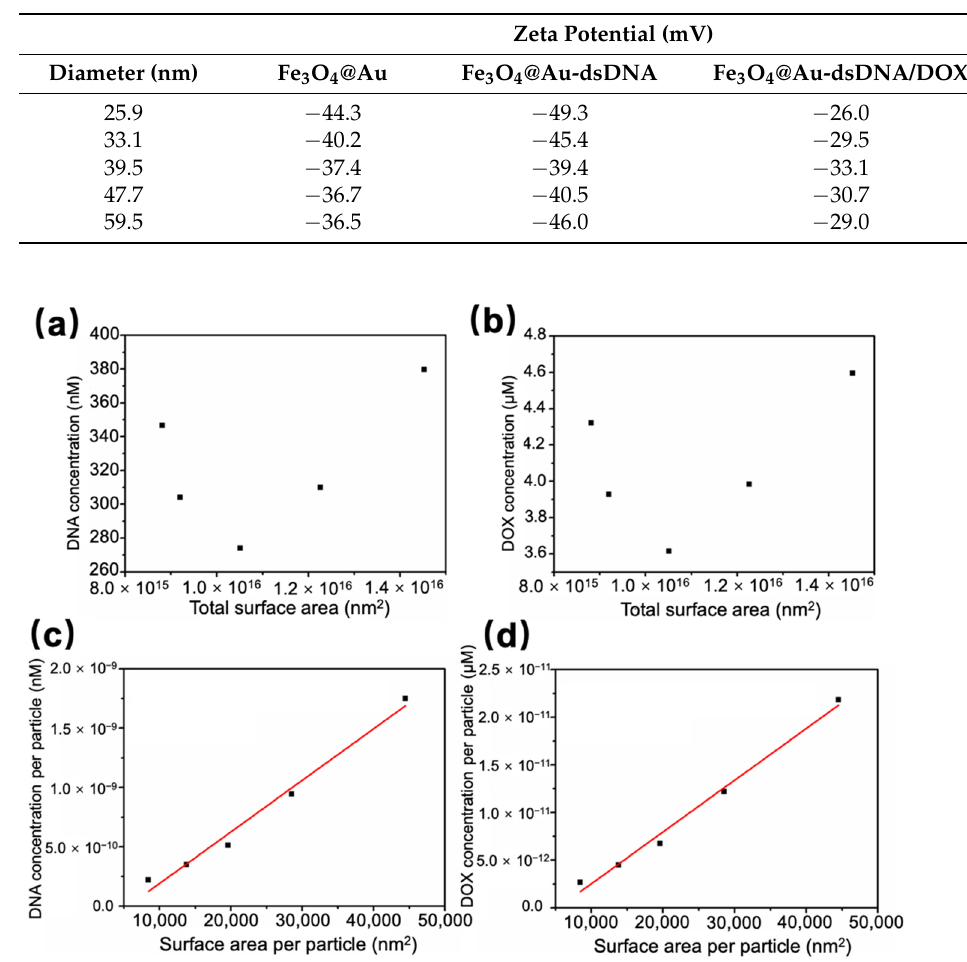
Figure 4. Relationship between the total surface area and ( a ) the DNA binding concentrations and ( b ) the DOX intercalating concentration. Relationship between the surface area per particle and ( c ) the DNA binding concentration per particle and ( d ) the DOX intercalating concentration per particle. Table 2. Zeta potential of different Fe 3 O 4 @Au NP, Fe 3 O 4 @Au NP-dsDNA, and Fe 3 O 4 @Au NP- dsDNA/DOX sizes.